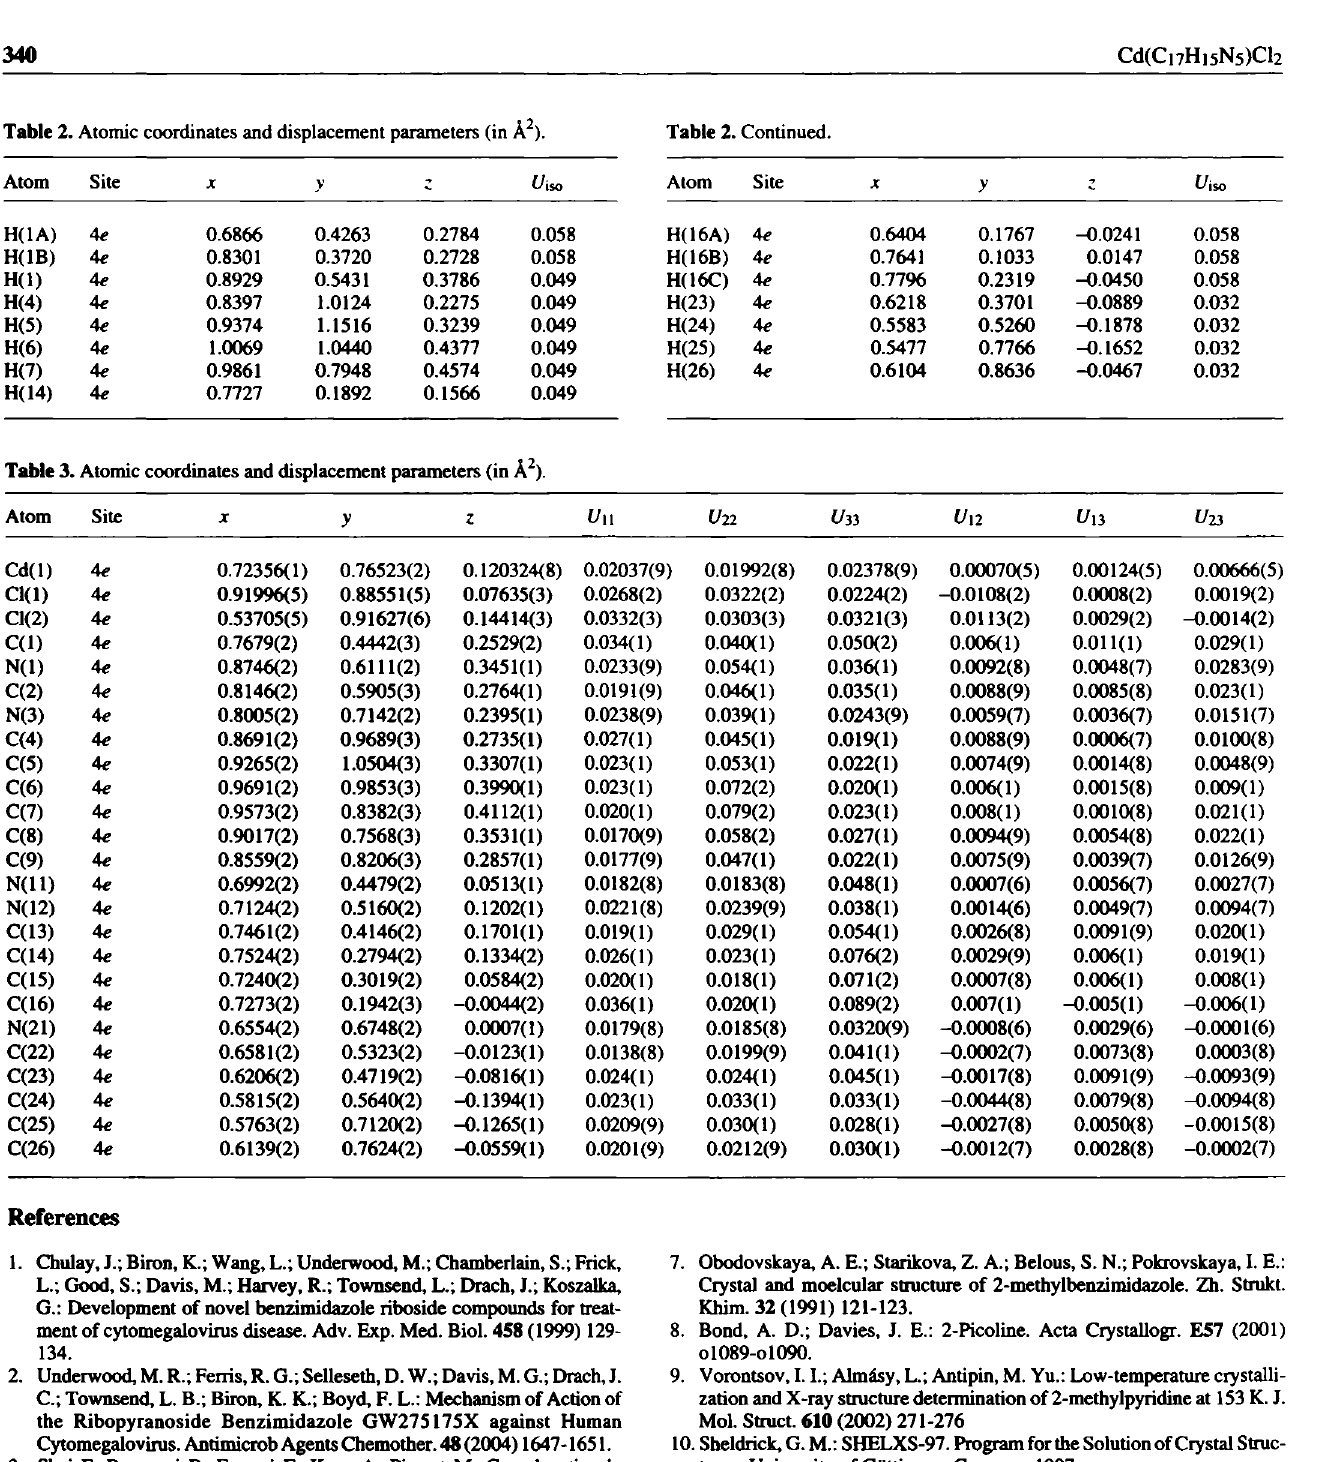
Table 2. Atomic coordinates and displacement parameters (in À 2 ).